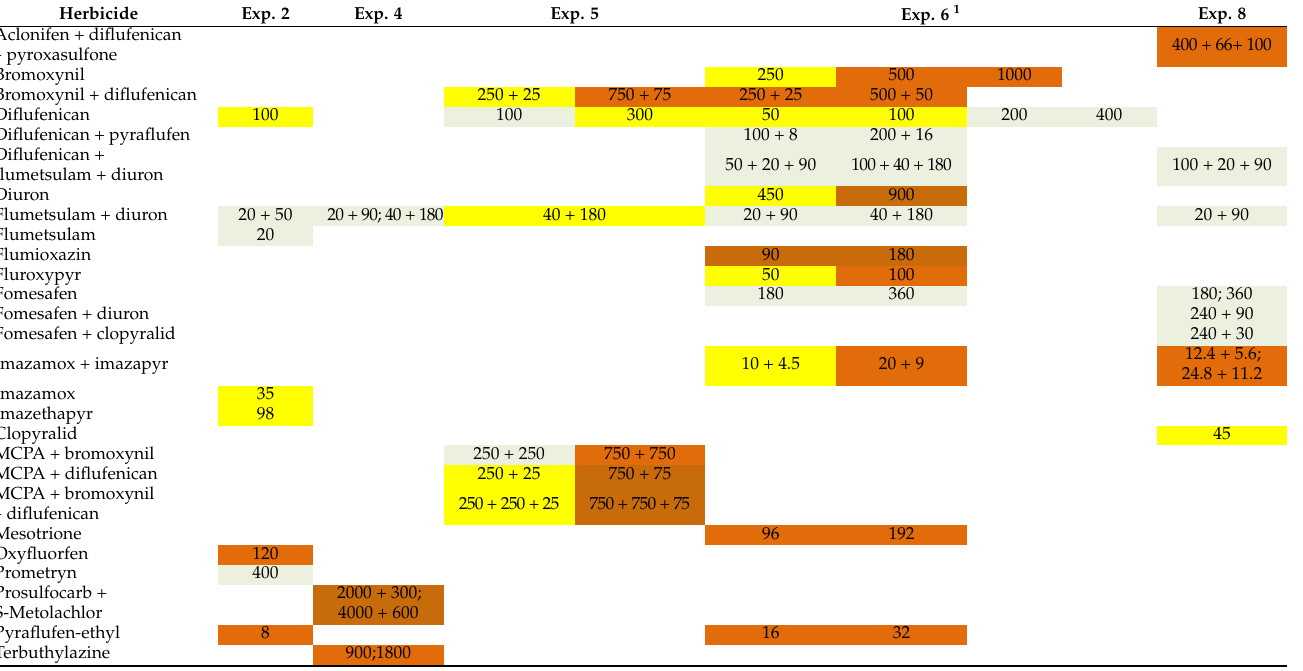
Table 16. Tolerance of 1 month old seedlings of Lanza ® tedera to post-emergent herbicides to control broadleaf weeds. Herbicides/rates (a.i. g/ha) in green or yellow were not significantly different to an un-sprayed control, with those in green causing less than 10% biomass reduction and those in yellow causing more than 10% biomass reduction. Those in red had significantly less biomass than the un-sprayed